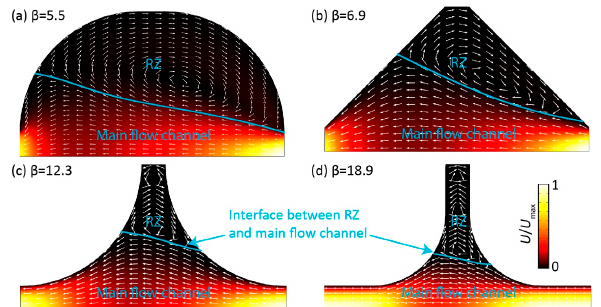
Figure 2. The normalized velocity fields encoded by color for four pore geometries with: ( a ) β = 5.5, ( b ) β = 6.9, ( c ) β = 12.3, and ( d ) β = 18.9, where the cyan line represents the interface between recirculation zone (RZ) and main flow channel, U is the magnitude of velocity with its maximum U max , the white arrow indicates flow field.